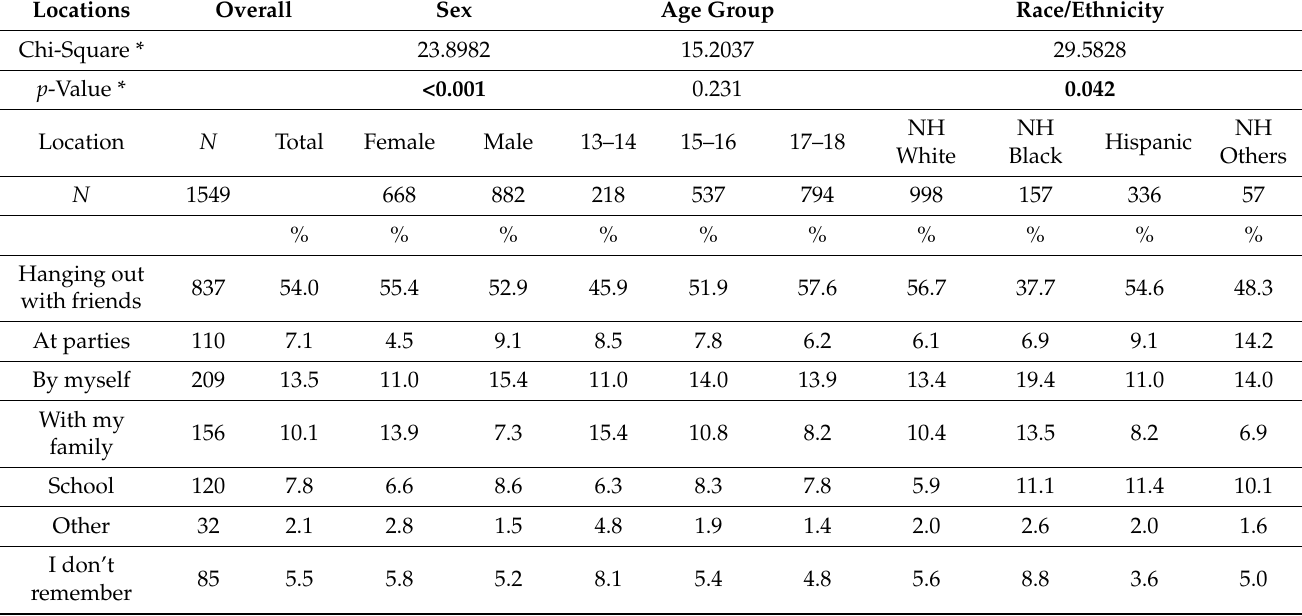
Table 5. Location of First ENDS Product Use, Overall and by Sex, Age, and Race/Ethnicity—Quantitative Survey. Locations